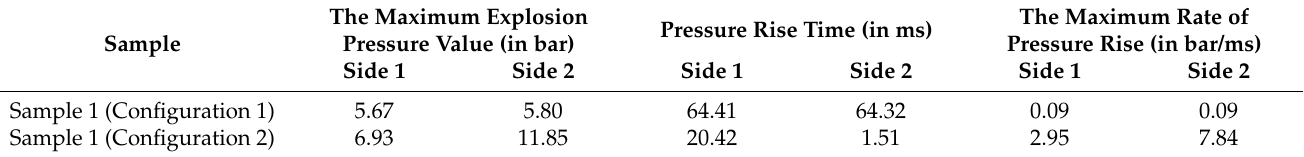
Table 3. Explosion pressure parameters of sample 1.